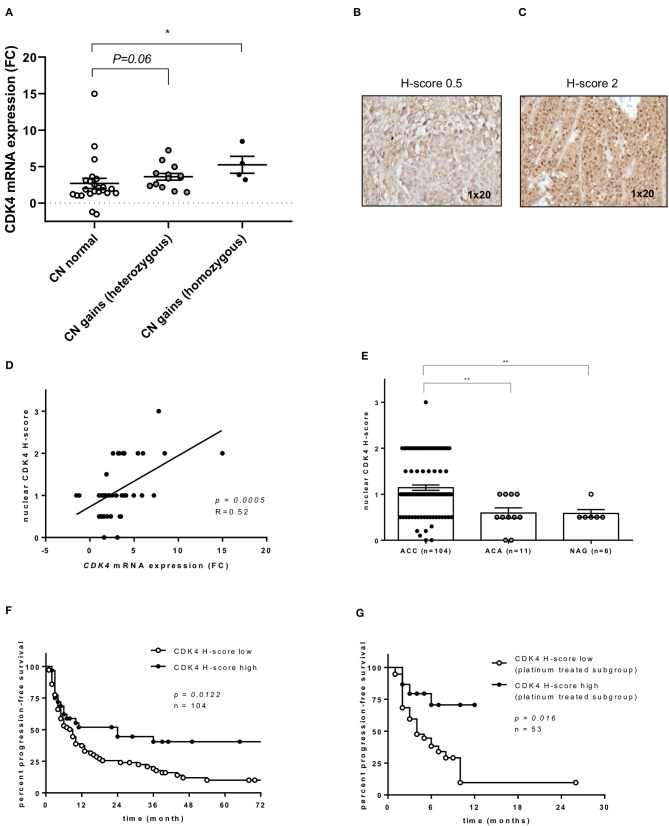
CDK4 gene expression and CDK4 nuclear protein expression in adrenocortical carcinoma (ACC). (A) Relationship between CDK4 gene expression and copy number (CN) status at DNA level (n = 40) (2): CDK4 mRNA fold changes (FC) in ACC with normal CN status (n = 23) or CDK4 CN gain heterozygous (n = 13) or homozygous (n = 4) as previously published. Bars represent median and interquartile range. *p < 0.05. Statistical analysis by Kruskal-Wallis test followed by Bonferroni post-hoc test. (B,C) Examples of CDK4 immunostaining in two ACC samples, one with negative nuclear staining (H-score = 0) and one with intermediate positive staining (H-score = 2). Magnification 1 × 20. (D) Relationship between CDK4 mRNA FC and CDK4 nuclear protein expression evaluated by immunohistochemistry (as H-score) (n = 40). The regression line is shown. Statistical analysis by Pearson r correlation test. (E) CDK4 nuclear protein expression evaluated by immunohistochemistry (as H-score) in normal adrenal glands (NAG, n = 6), adrenocortical adenomas (ACA, n = 11) and ACC samples (n = 104) (p < 0.0002 per trend). Bars represent median and interquartile range. **p < 0.01. Statistical analysis by Kruskal-Wallis test. (F) Progression-free survival curves comparing low CDK4 expression defined as H-score ≤ 1 (n = 72) and high expression defined as H-score > 1 (n = 32). Statistical analysis by log-rank test. (G) Time to progression in platinum-treated ACC cohort (n = 53) comparing low expression (n = 38) and high expression (n = 15) as defined above. Statistical analysis by log-rank test.